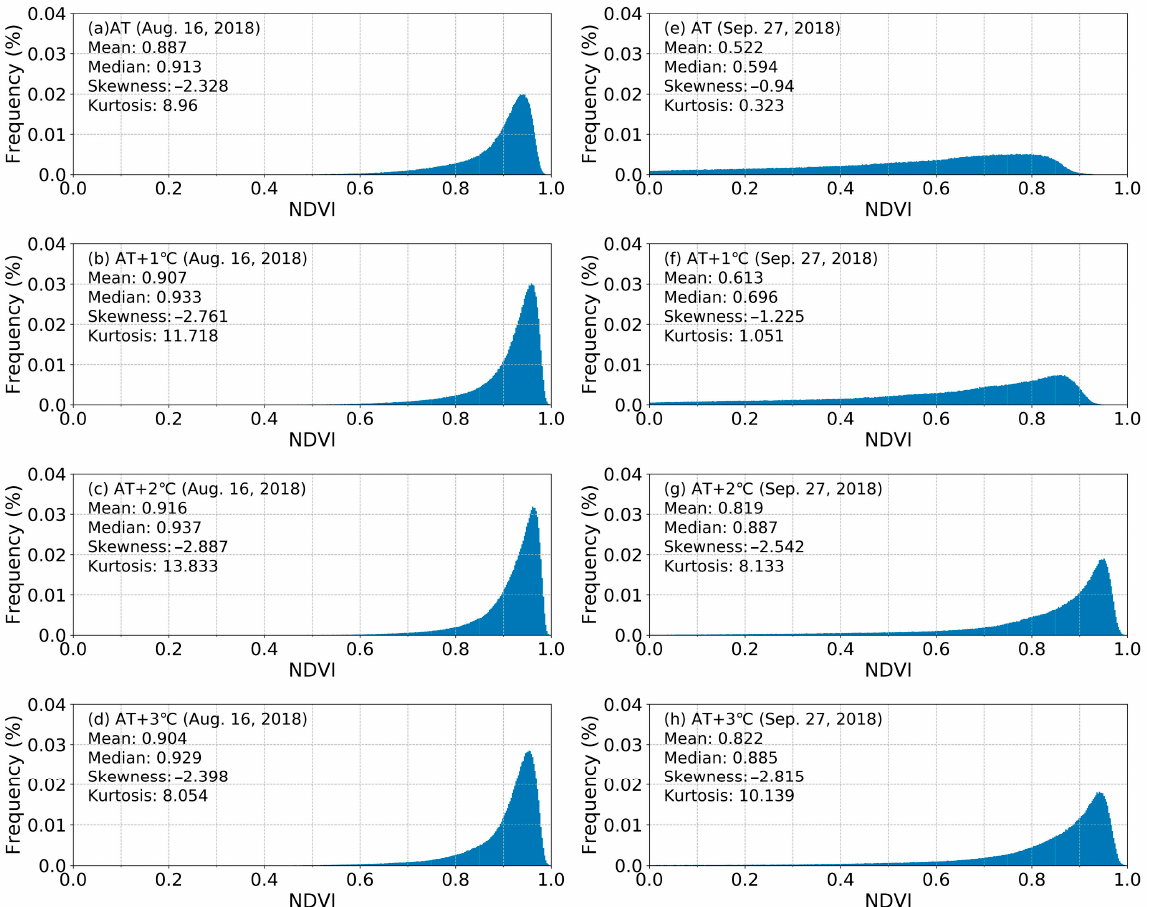
Figure 10. Distribution of NDVI for vegetation pixels on 16 August 2018 (heading stage) ( a – d ) and 27 September 2018 (harvesting stage) ( e – h ) under different air temperature conditions. NDVI was calculated based on spectral reflectance captured by the multi-spectral camera.